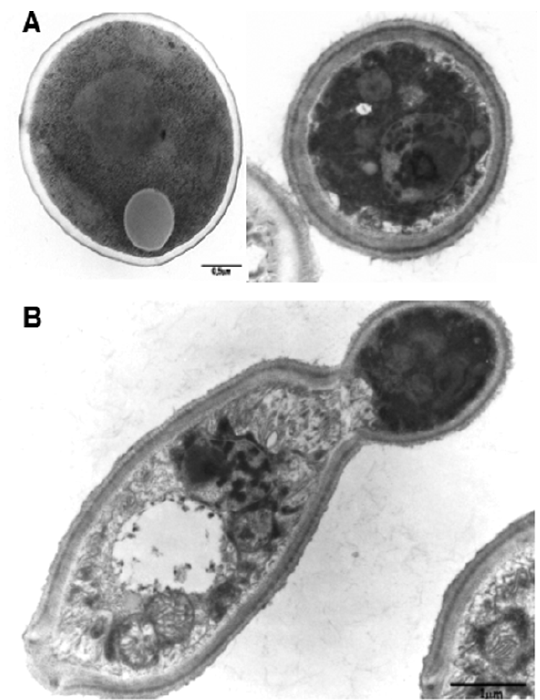
Fig. 1 – Electron micrographs showing the cytotoxic effects of the killer peptide (KP) on Candida albicans. ( A ) Normal untreated or treated with the inactive scrambled peptide C. albicans yeast cell (left) as compared with the KP-treated yeast cell (right). Major alterations can be seen as the swelling of the cell wall, plasma membrane collapse, chromatin condensation and nuclear fragmentation. ( B ) An elongated C. albicans cell with a budding cell, both affected by KP treatment. The same alterations as in (A) are seen with nuclear fragmentation and cytoplasmic blebs invading the daughter cells beyond the